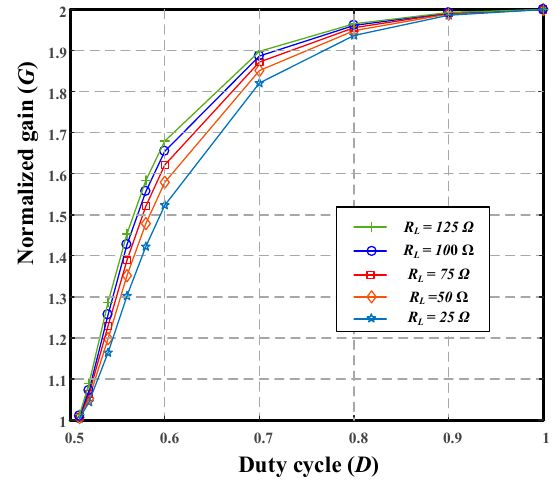
Figure 5. Voltage gain in PWM mode versus equivalent R L and D .